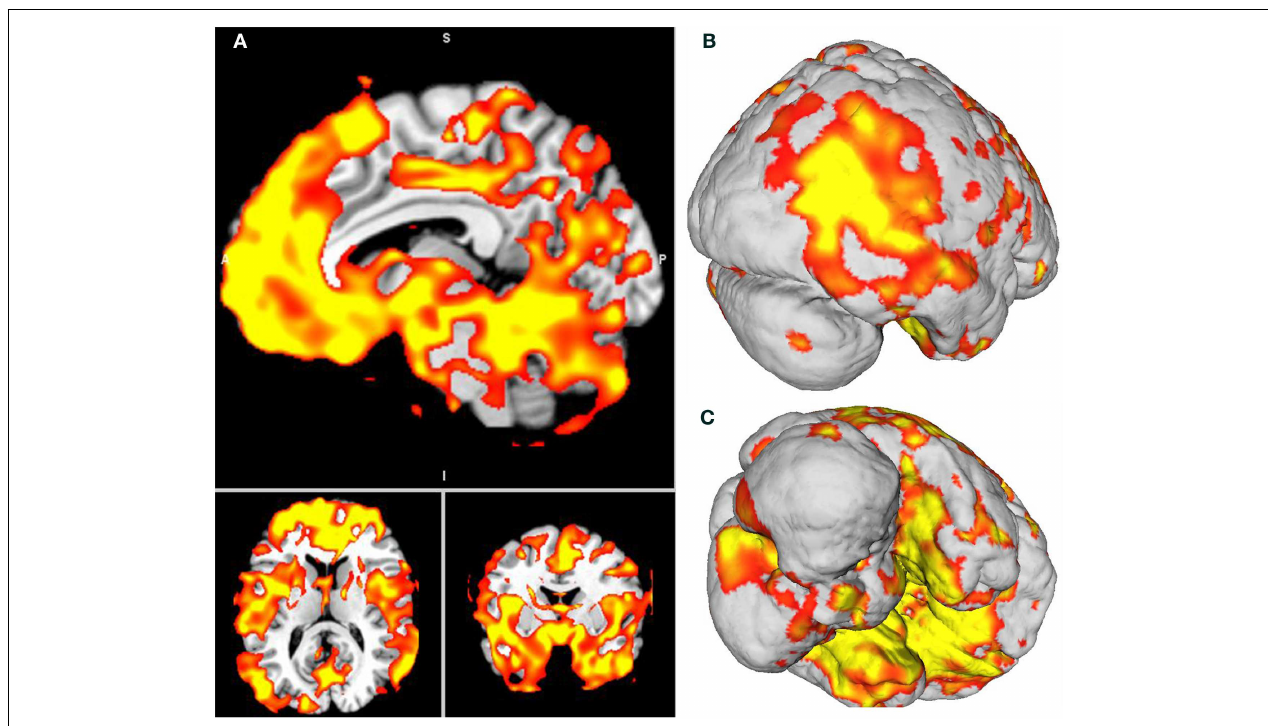
FIGURE 3 | (A) Patient F atrophy obtained through voxel-based morphometry analysis. All slices are p < 0.001, Bonferroni-corrected ( α , 0.05, FWE). (B,C) Surface-based 3D reconstruction of patient F’s atrophy plotted over a standard brain in MNI